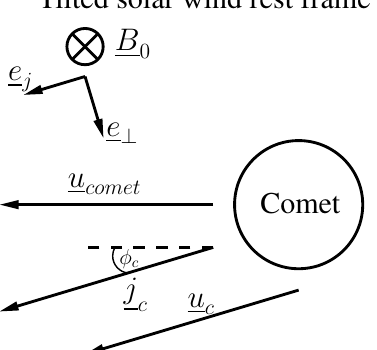
Figure 1. Illustration of the cometary rest frame CSEQ (top), solar wind rest frame SW (mid) and tilted solar wind rest frame TSW (bottom).